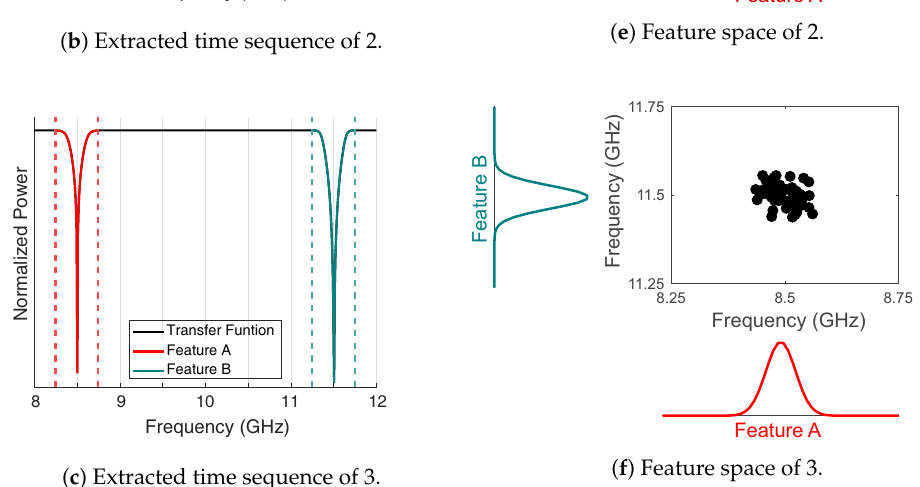
( f ) Feature space of 3.